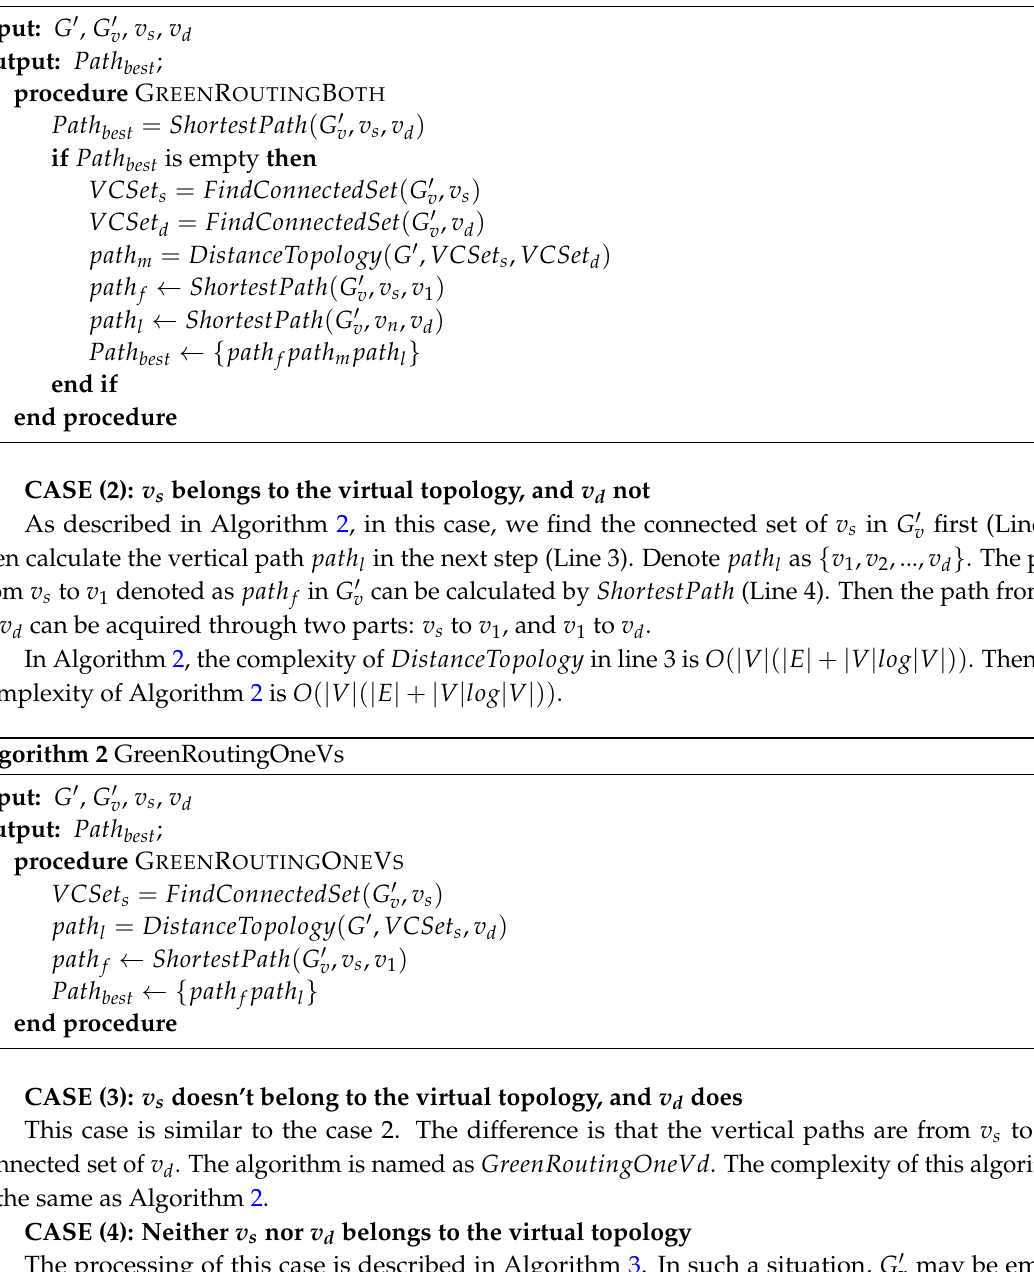
Algorithm 1 GreenRoutingBoth